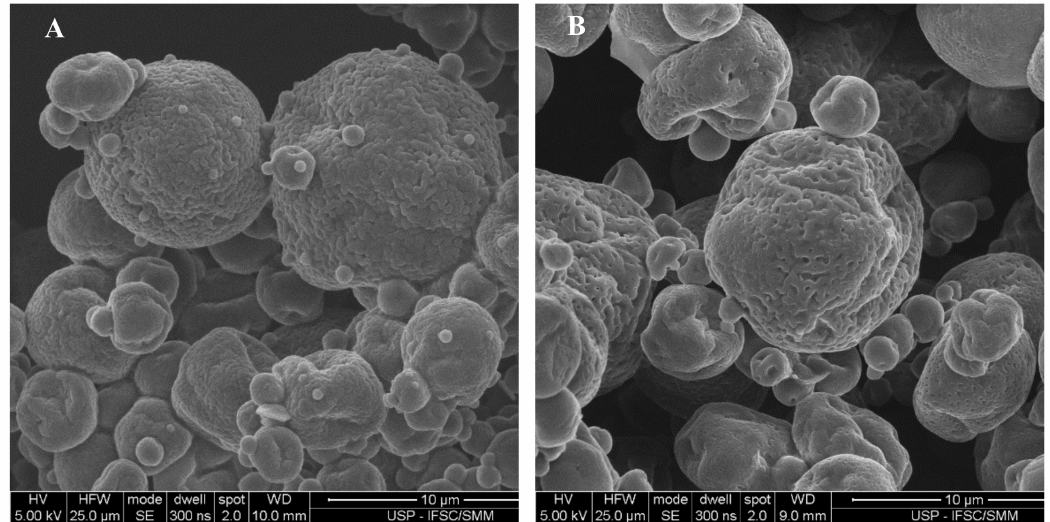
Figure 3. Typical morphology of spray-dried lipid-based formulations: F7A1 ( A ); F7A2 ( B